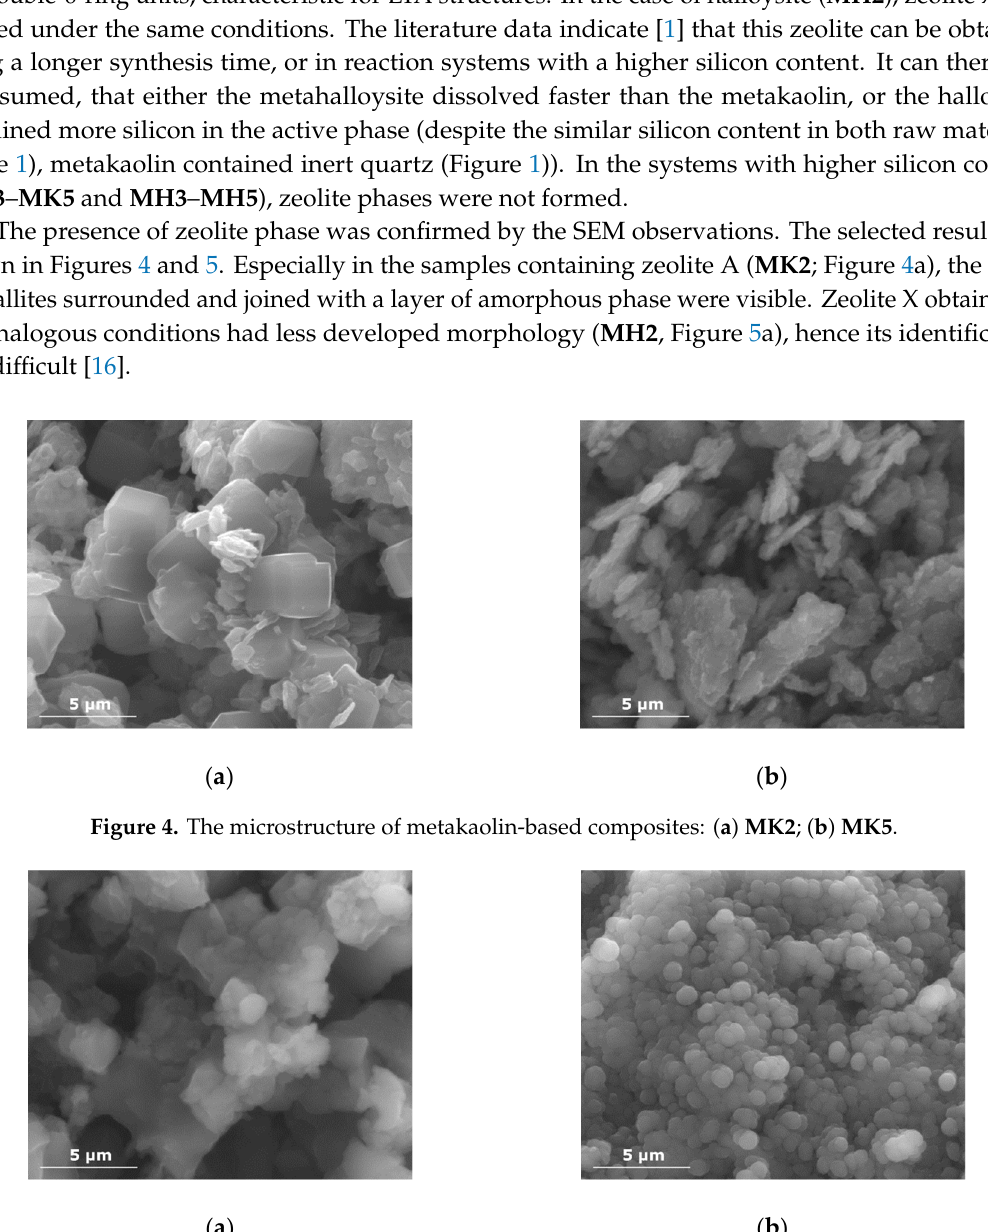
Figure 3. The XRD patterns of alkali-activated: ( a ) metakaolin; ( b ) metahalloysite.